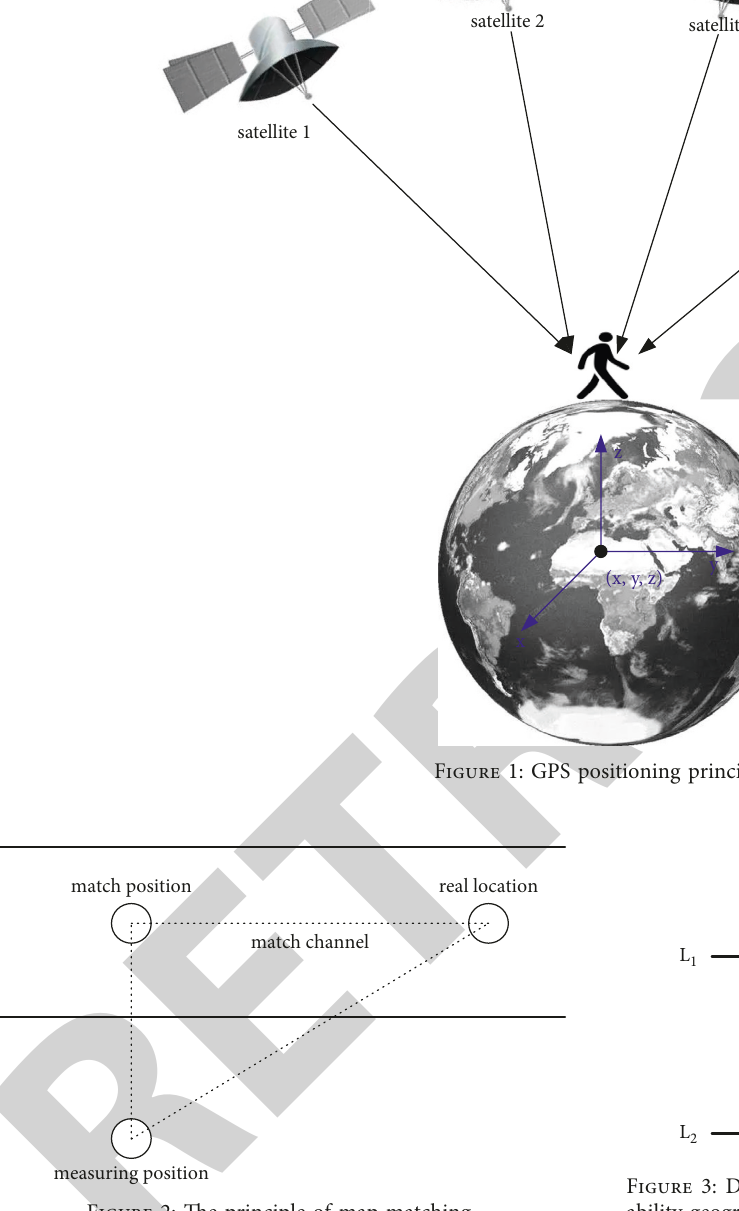
Figure 2: The principle of map matching.